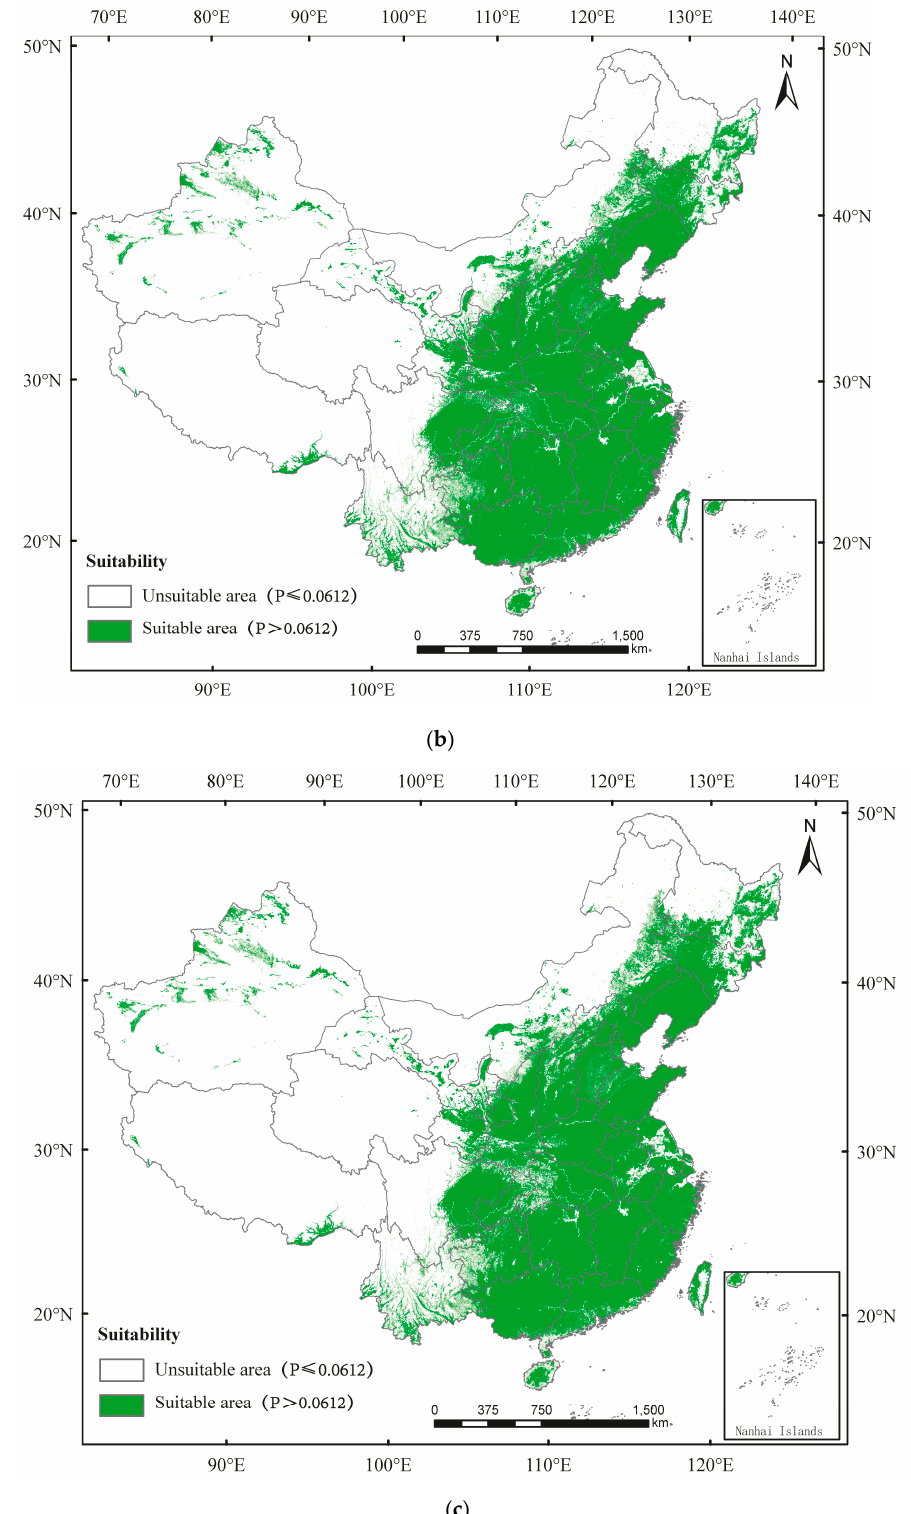
Figure 3. Potential distribution of Dastarcus helophoroides in China predicted using the MaxEnt model under ( a ) the current climate and according to climate change in ( b ) 2050 and ( c )